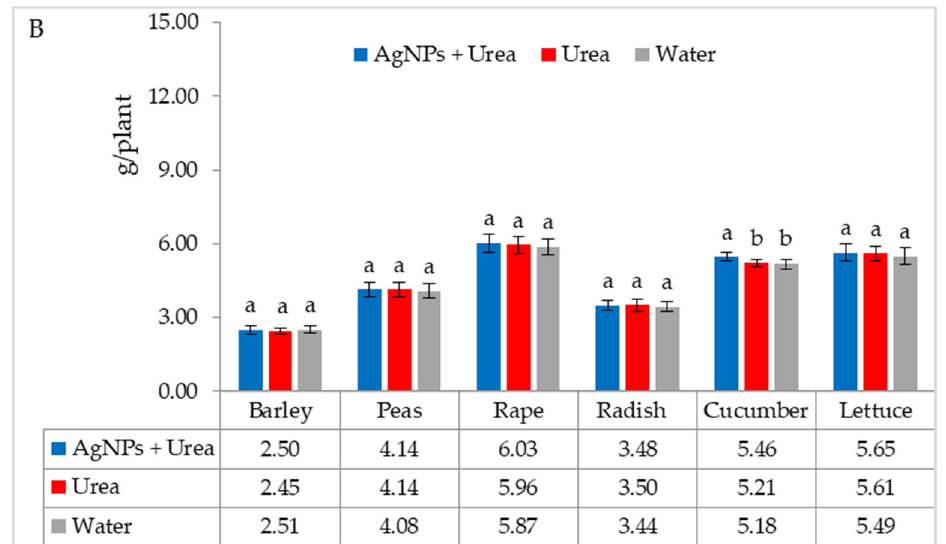
Figure 7. Plant biomass under optimal—( A ) and water stress conditions—( B ) depending on the presence of AgNPs in the substrate; urea solution with AgNPs (AgNPs + Urea), urea solution (Urea), water (Water). a, b—letters indicate a significant difference in the biomass of individual plant species at p < 0.05.